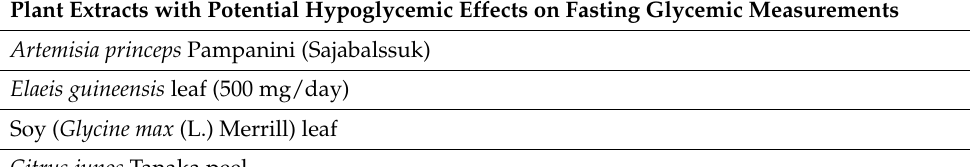
Table 3. Hypoglycemic effects of plant extracts on fasting and postprandial glycemic measurements. Plant Extracts with Potential Hypoglycemic Effects on Fasting Glycemic